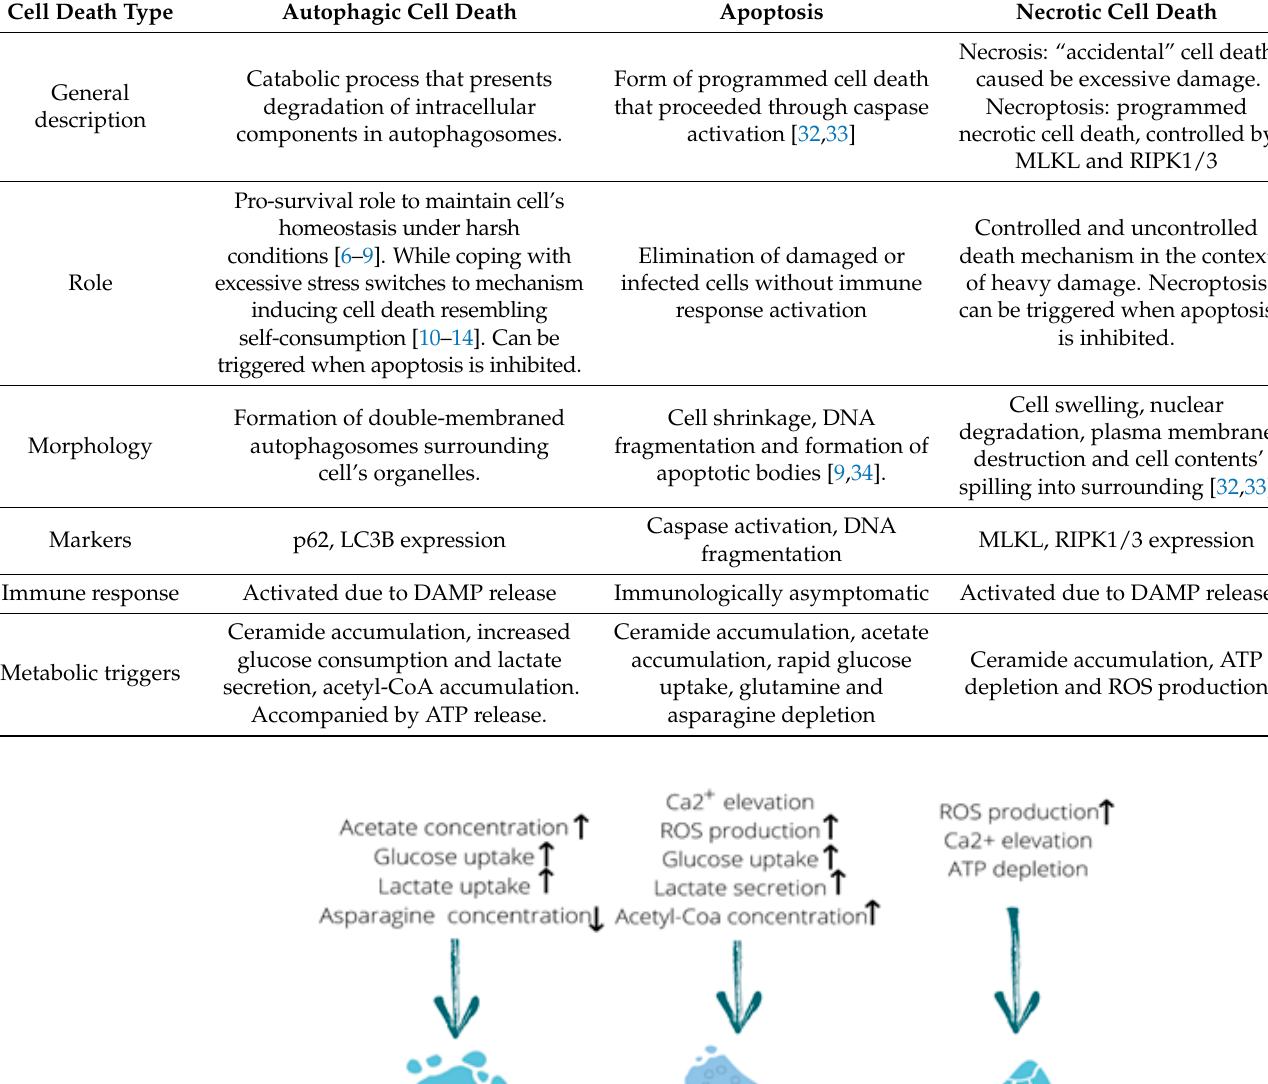
Table 1. The three types of adenovirus-induced cell death.